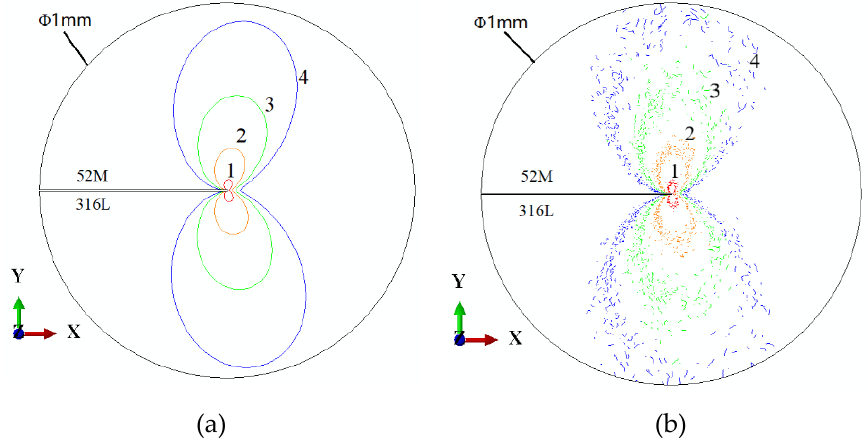
Figure 7. Plastic zone at the crack tip of the fusion line specimen (where equivalent plastic strain is 0.2% and contours 1, 2, 3, and 4 are the plastic zone boundaries for applied loads K I : (1) K I = 10, (2) K I = 20, (3) K I = 30, (4) K I = 40 MPa m 1/2 ). ( a ) Homogeneous material; ( b ) inhomogeneous